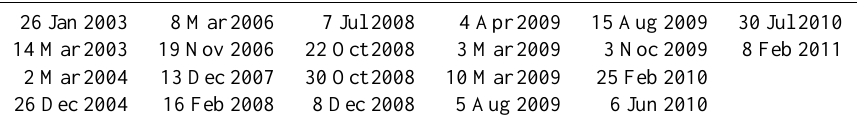
Table 1. List of days in the period January 2003 to April 2011 with suspicious data in the MODIS MOD14